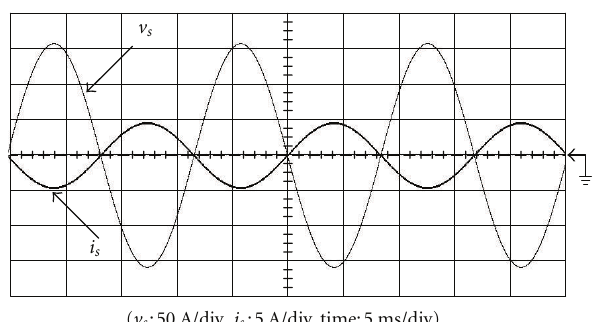
Figure 16: Filtered line current and line voltage during the interval of high insolation.